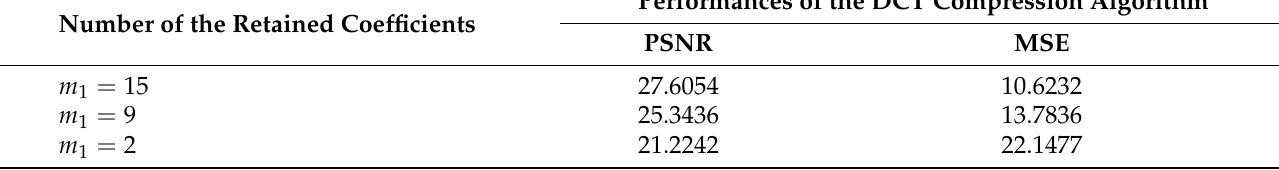
Table 2. Experimental results achieved by implementing the DCT compression